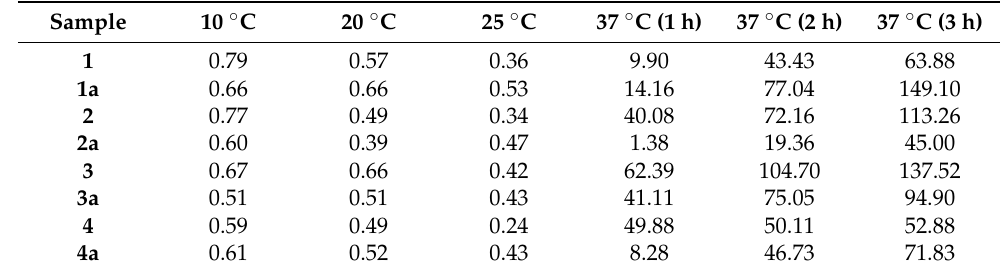
Table 2. The G’ values (in Pa) for samples 1 – 4 and 1a – 4a corresponding to a frequency value of 1